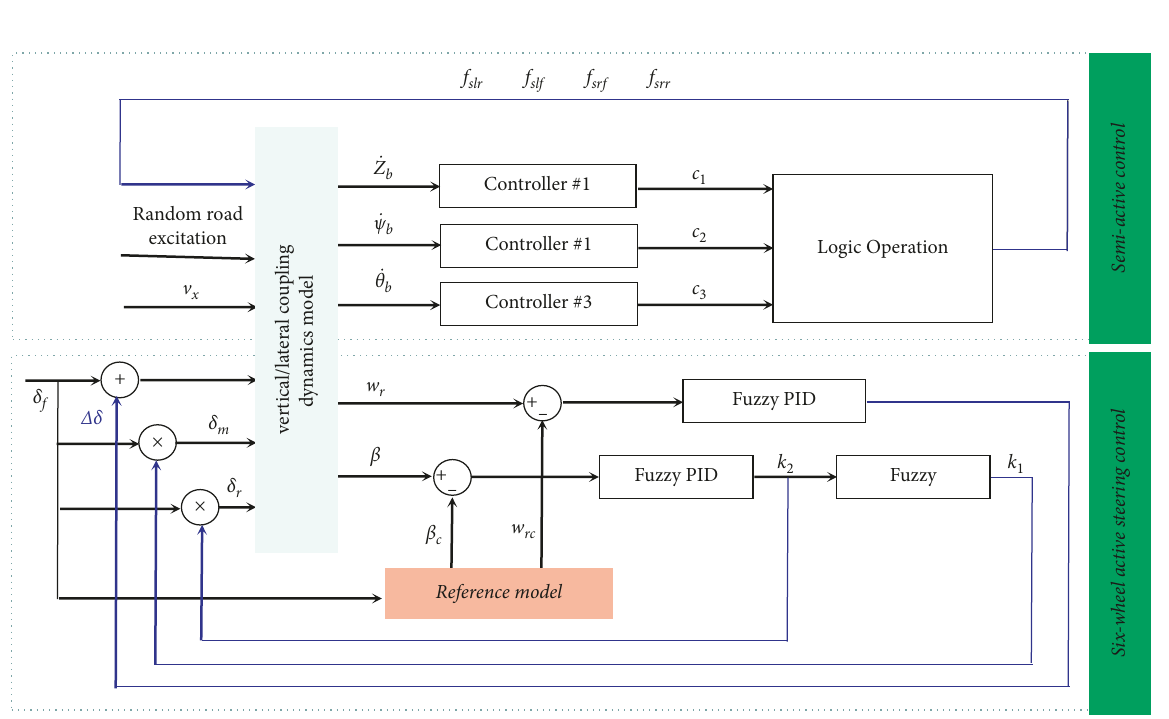
Figure 4: Simulation model of vehicle ride comfort and steering stability synchronous